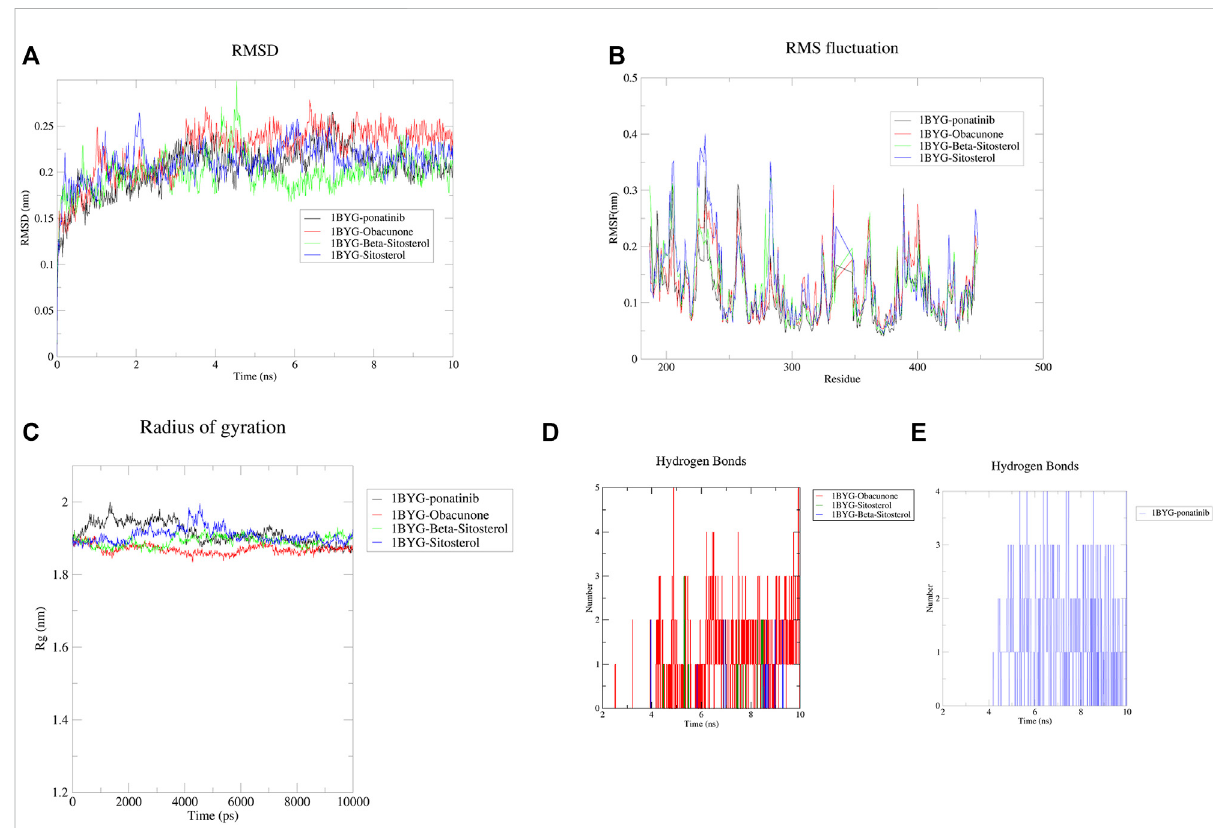
FIGURE 9 The results of Molecular dynamics simulation. (A) RMSD curve of protein-ligand complexes; (B) RMSF curve of protein-ligand complexes; (C) Radiusofgyrationofcomplexes; (D) Thenumberofhydrogenbondsformedbetweentheactivecompoundsand1BYG; (E) Thenumberofhydrogen bonds formed between Ponatinib and 1BYG. In (A – C) , 1BYG-ponatinib, 1BYG-Obacunone, 1BYG-Beta-sitosterol, and 1BYG-Sitosterol are represented by black, red, green, and blue curves,